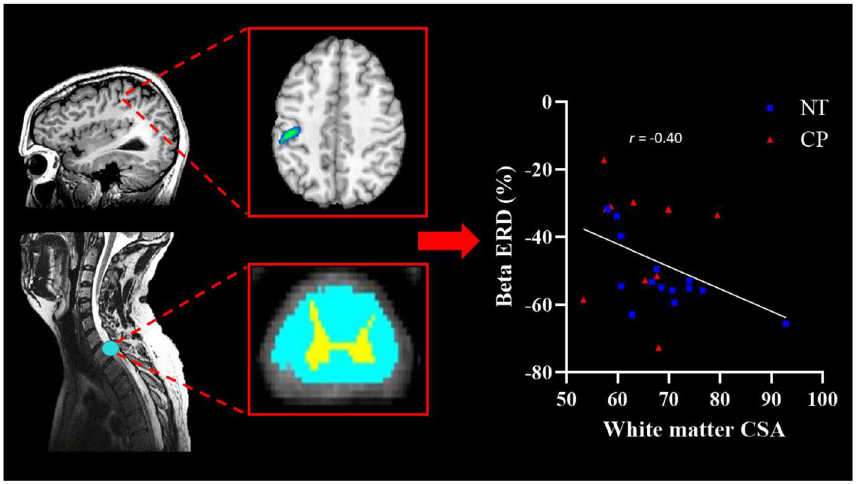
Figure 7. Cortical oscillations drive changes in spinal cord microstructure. Left : Representative T1 weighted images of the brain and spinal cord from an adult with CP. The light blue circles denote the area of the brain and spinal cord that the strength of the beta ERD and white matter cross sectional area (CSA) were taken, respectively (Talairach coordinates: − 42, − 24, 21; spinal cord section: C6–T3). Middle : Representative beta ERD response (top) and CSA of the spinal cord (white matter depicted in light blue and gray matter depicted in yellow). Right: Scatterplot depicting the relationship between the strength of the beta ERD and the white matter CSA. Individuals with a stronger beta ERD tended to have more white matter within their upper spinal cord ( r = − 0.40, P = 0.048) and more total CSA ( r = − 0.43, P = 0.031). Blue squares denote controls while red triangles reflect those with